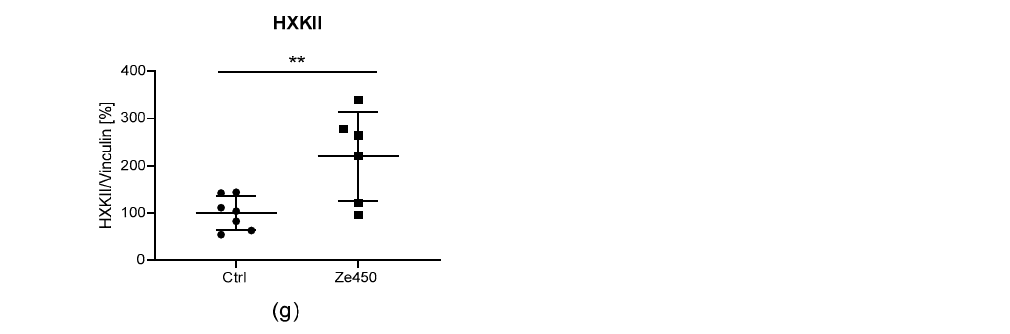
Figure 3. Effects of Ze 450 on protein levels of metabolic key regulators. ( a ) Effects of 100 µg/mL Ze 450 on HIF1 α protein levels were investigated via Western Blot after 2–16 h treatment in HT22 cells. ( b ) Quantification of Western Blot after 2–16 h of treatment with 100 µg/mL Ze 450 depicted as optical density compared to β -Actin as loading control ( n = 5/treatment condition; *** p < 0.001; ** p < 0.01; unpaired t -test). ( c ) Representative Western Blot showed the effect of 100 µg/mL Ze 450 treatment on cMyc protein level after 2–16 h treatment in HT22 cells. ( d ) Quantification of Western Blot as optical density compared to β -Actin as loading control ( n = 3/treatment condition; ** p < 0.01; unpaired t -test). ( e ) Representative Western Blot of PDK1, and HXKII protein levels after 16 h of Ze 450 treatment (100 µg/mL) in HT22 cells. ( f , g ) Quantification of Western Blot as optical density compared to vinculin as loading control ( n = 8/treatment condition, *** p < 0.001; ** p < 0.01, unpaired t -test).